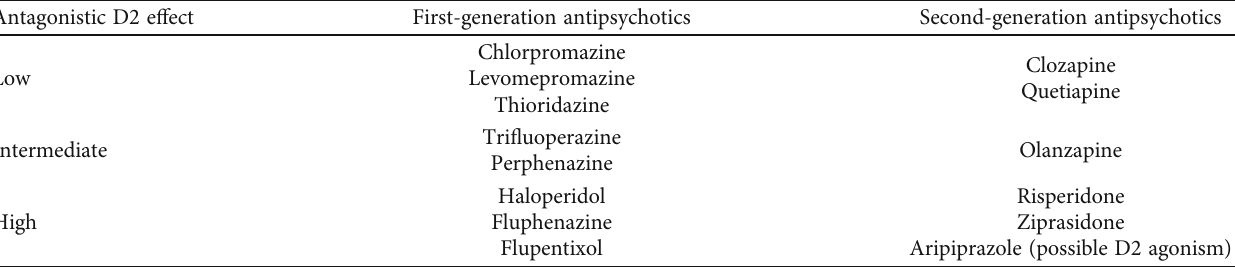
Table 1: [17] First- and second-generation antipsychotics and D2